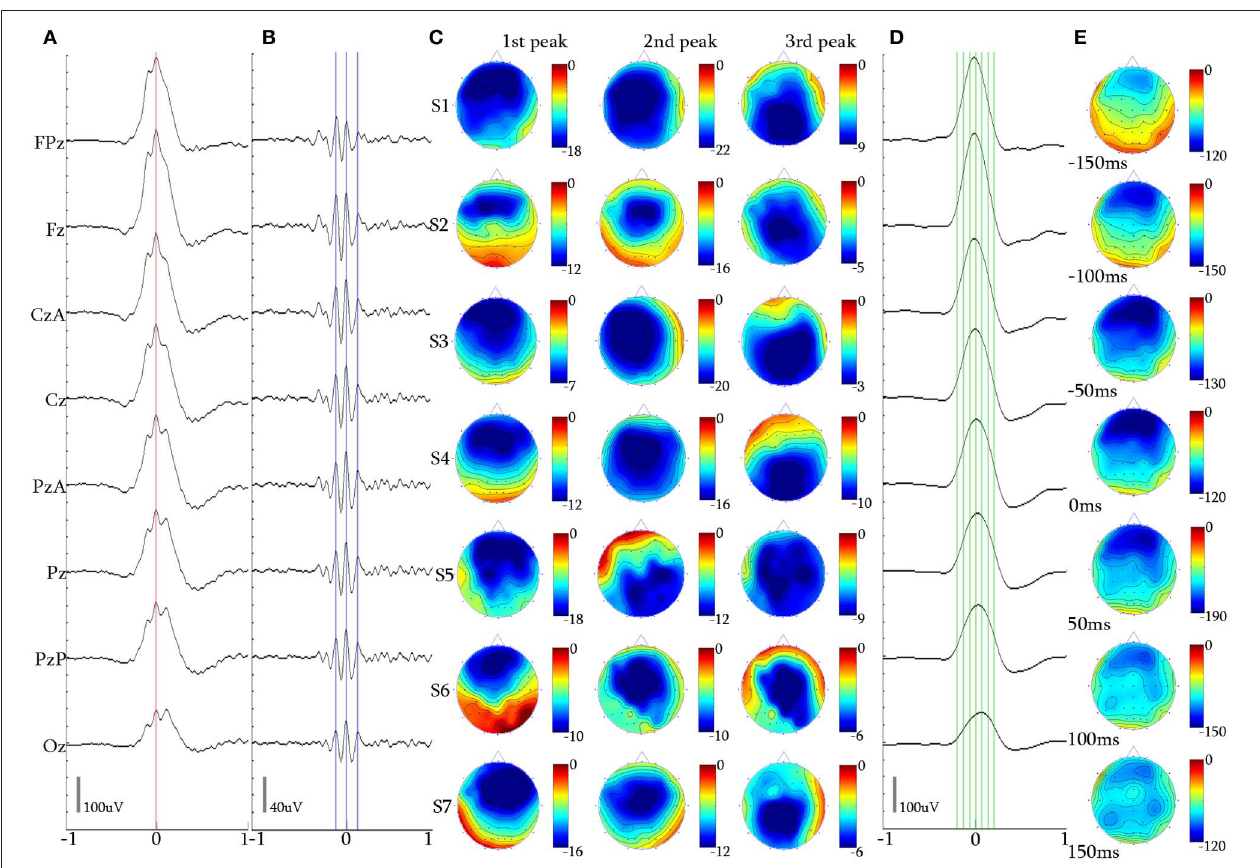
FIGURE 5 | 3-peak iKCo. (A) Waveform averaged KC—unfiltered EEG signal of subject 1. (B) 5Hz high-pass filtered waveform of the averaged KC signal, of the same subject. (C) Topographic analysis in 2D electrode space for all subjects (S1–S7) of the 1st, 2nd, and 3rd peaks of the iKCo. Note than maximal power of the first, second and third wave was, respectively, located in frontal, central and parietal areas—with